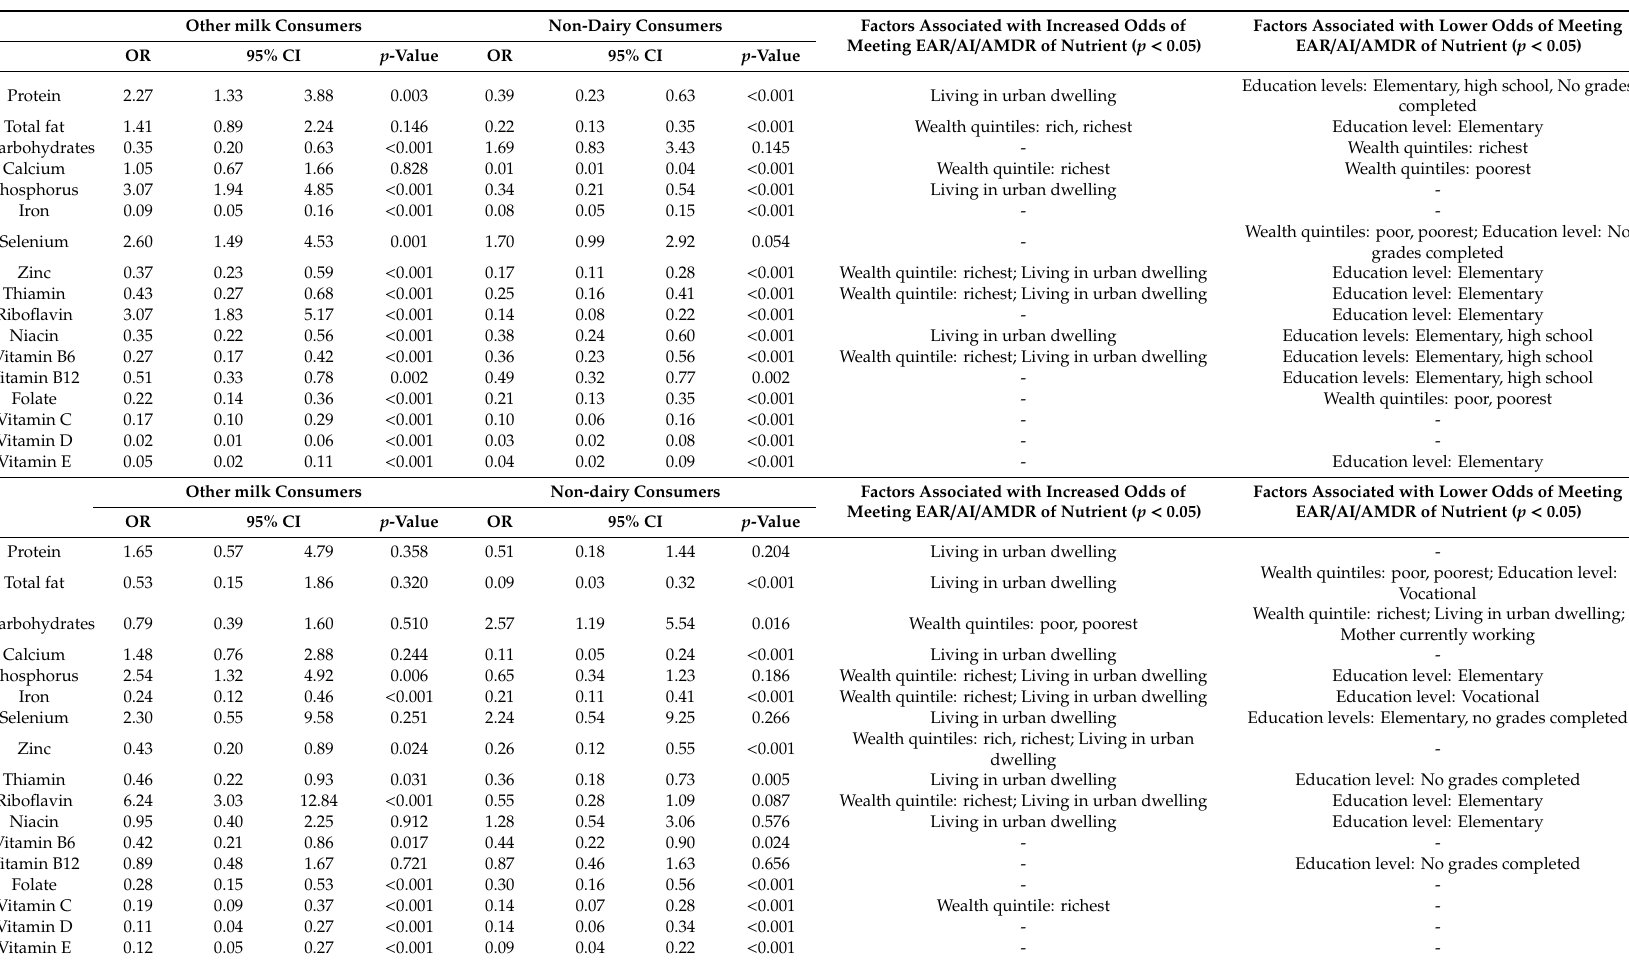
Table 4. Odds ratios of children meeting the estimated average requirements / adequate intake / Acceptable Macronutrient Distribution Ranges (EAR / AI / AMDR) of each nutrient by consumer group compared to YCM / PCM consumers (reference) in age groups one to two years and three to four